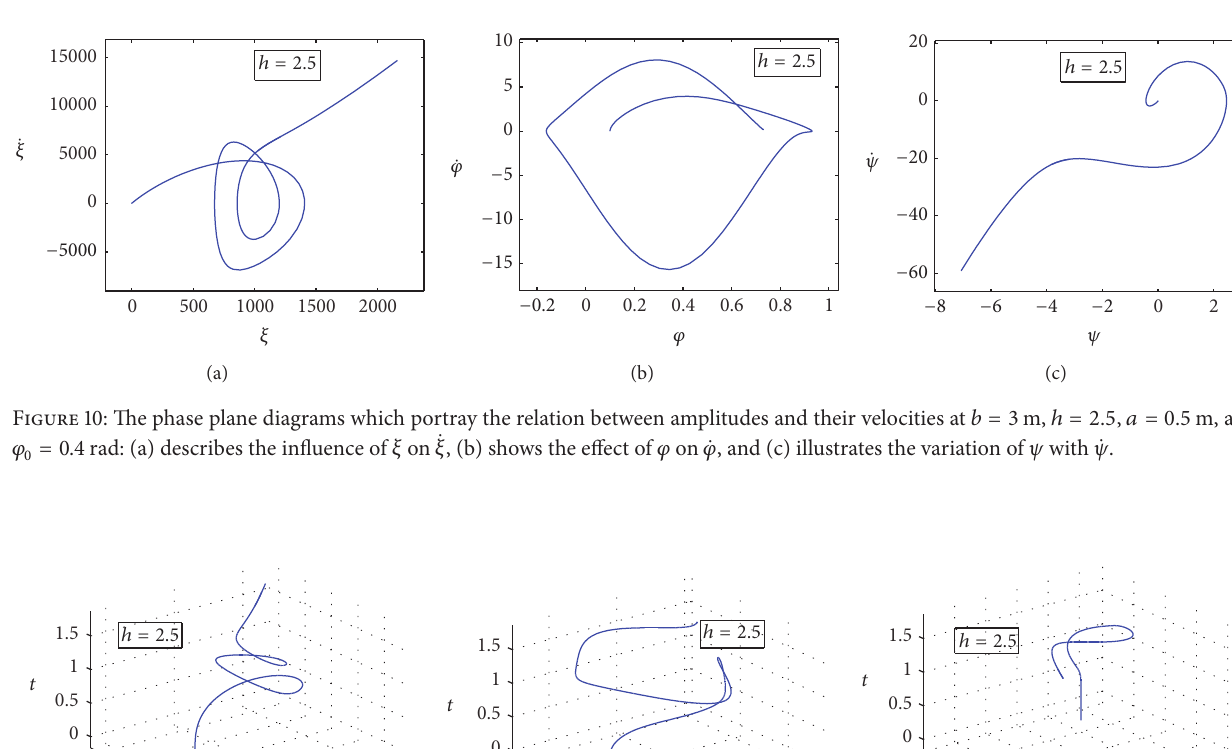
Figure 11: The 3D patterns at 𝑏 = 3 m, ℎ = 2.5 , 𝑎 = 0.5 m, and 𝜑 0 = 0.4 rad: (a) illustrates the variation of 𝜉 and variation of 𝜑 and ̇𝜑 versus 𝑡 , (c) illustrates the variation of 𝜓 and ̇𝜓 versus 𝑡